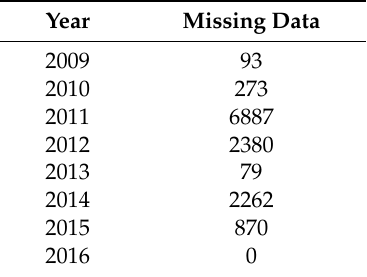
Table 1. Number of missing or bad data for each year’s time series. Full time series of one-minute sample data are 525600 (527040 for leap year)